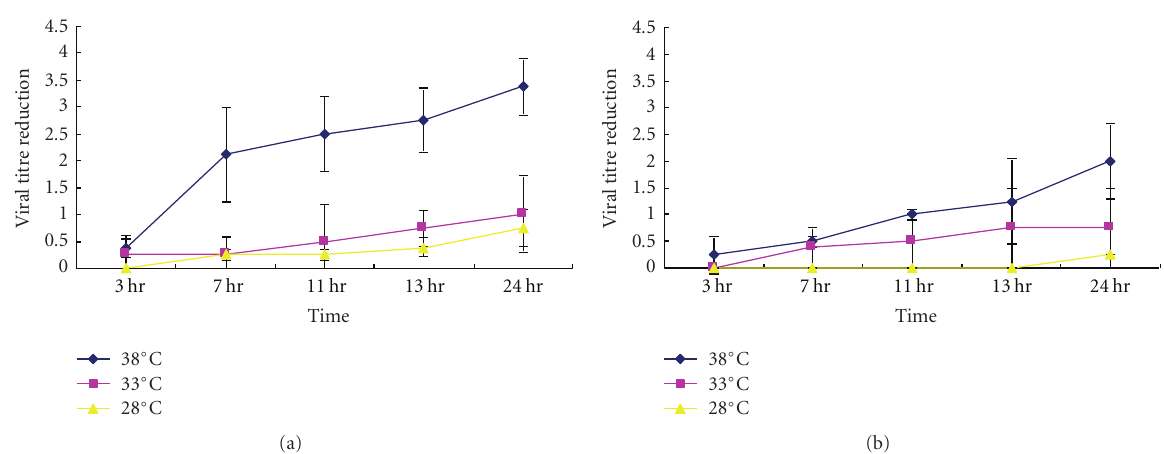
Figure 2: Infectivity of SARS Coronavirus (10 5 /10 μ L) to di ff erent temperatures at (a) > 95% relative humidity, (b) > 80–89%.